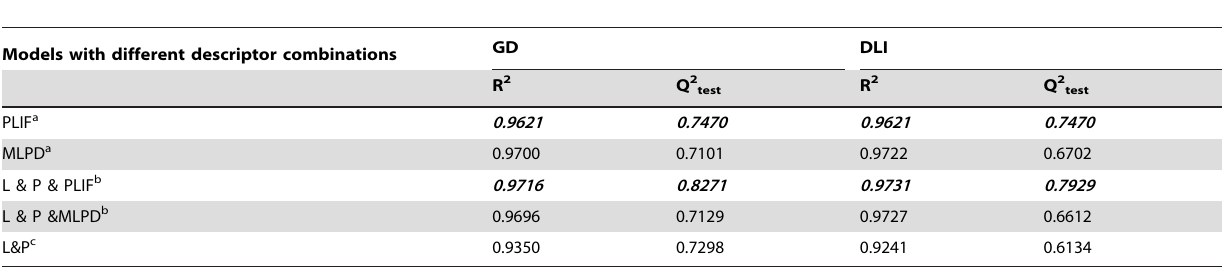
Table 3. Goodness-of-fit (R 2 ) and predictive ability (Q 2 test ) of the obtained models.